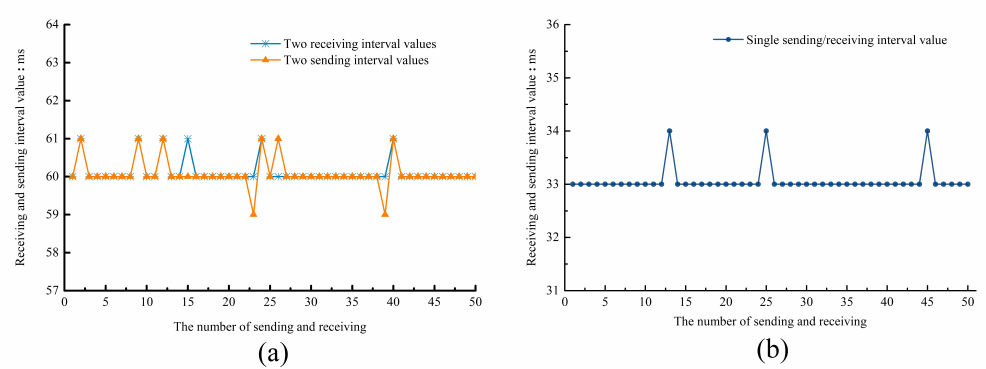
Figure 9. The interval values are the time for the test software to send and receive data under fixed load. Judging the capability of the DPU’s analog output by its two interval values. ( a ) Statistics of AO sending and receiving interval values. ( b ) Statistics of AO sending and response data